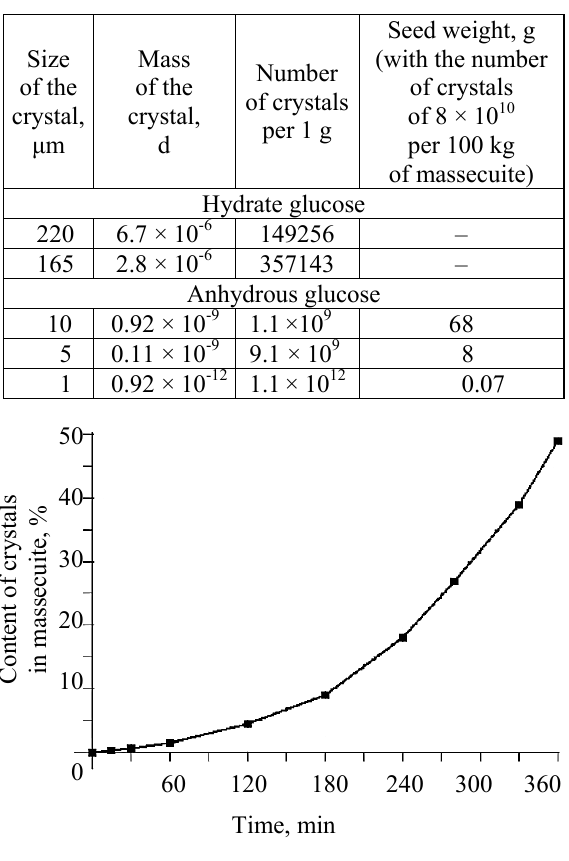
Fig. 6. Kinetics of nucleation and growth of the crystalline mass of anhydrous glucose under isothermal conditions with a seed from the hydrate crystals wet with propanol, when boiling massecuite in a vacuum apparatus at a temperature of 70–68°C.